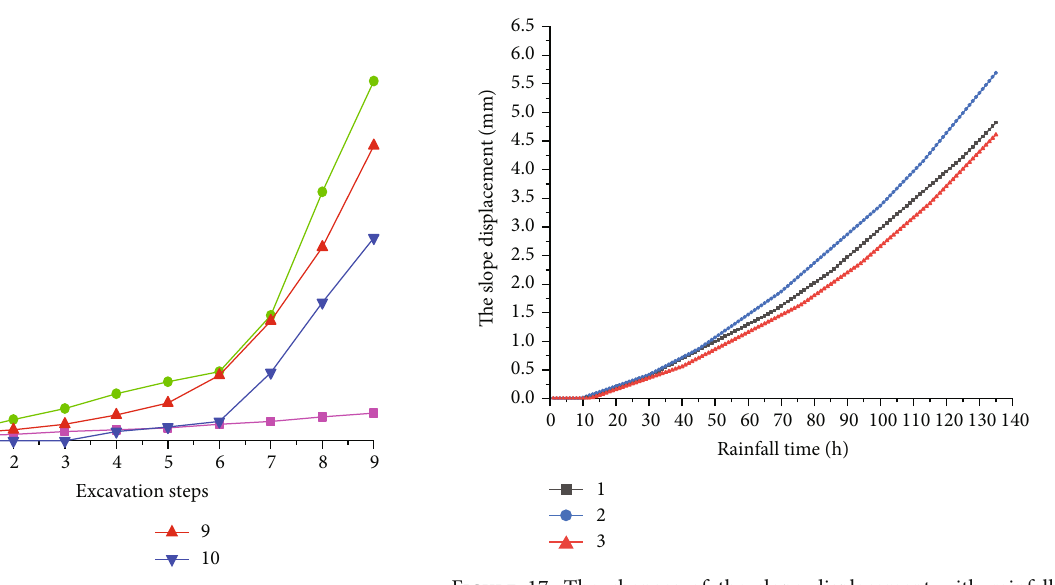
Figure 15: The changes of the displacement of the tunnel vault with excavation steps.